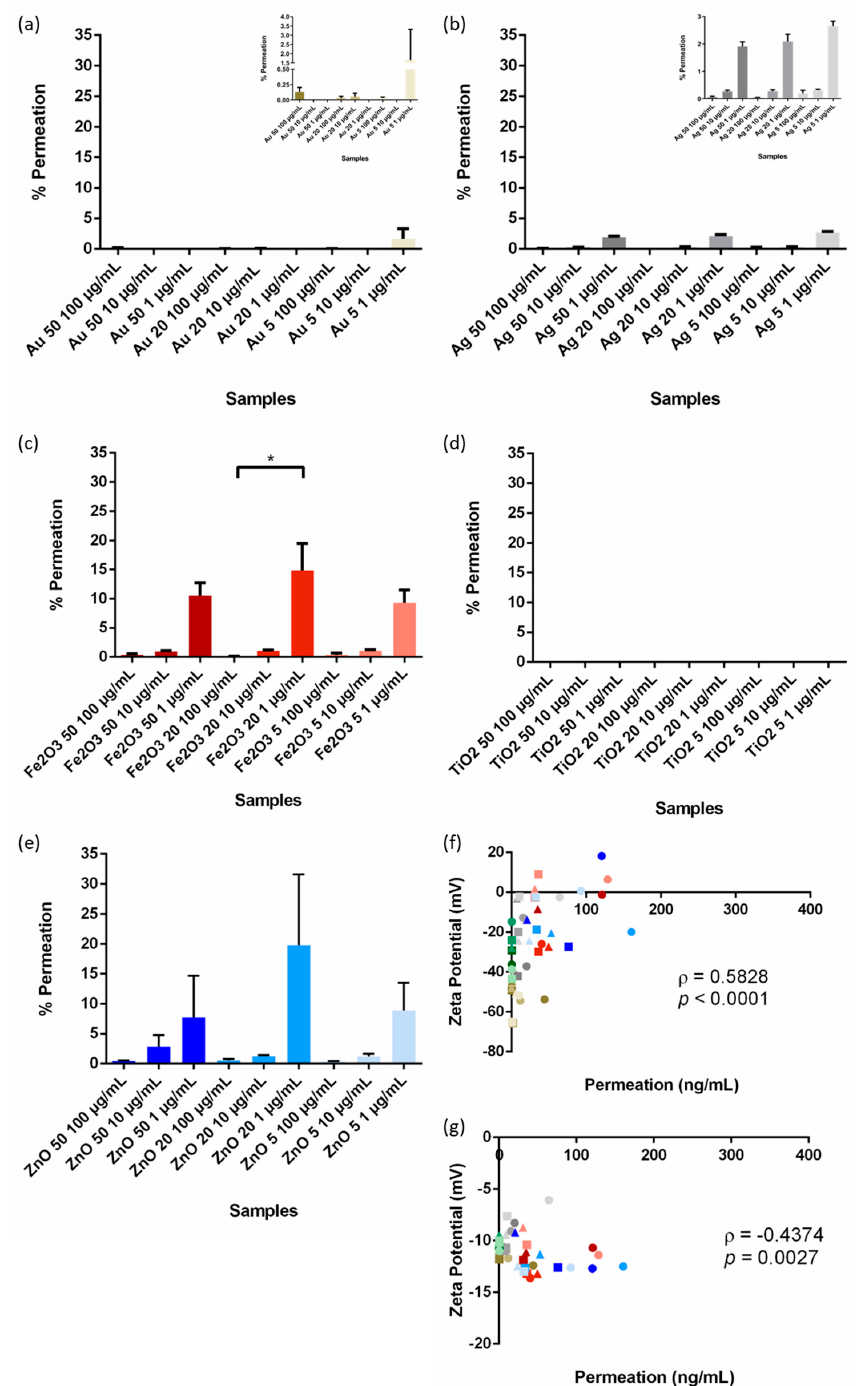
Figure 2. NP permeation across the cell barrier, as a percentage of the applied dose, following 12-h incubation with ( a ) gold, ( b ) silver, ( c ) iron (III) oxide, ( d ) titanium dioxide (there was no permeation of NPs found in all tests and all values found were zero i.e., the chart is blank), and ( e ) zinc oxide nanoparticles. For several samples, particularly all TiO 2 based NPs, no material could be detected by the ICP-MS in the permeate and hence the percentage permeation is noted as 0%. ( f ) Spearman’s correlation between NP permeability and nanoparticle zeta potential in water. ( g ) Spearman’s cor- relation between NP permeability and nanoparticle zeta potential in media. In the sca tt erplots ● = 100 µg/mL dose, ■ = 10 µg/mL, Δ = 1 µg/mL, * = 0.01 < p < 0.05. Note: levels were almost undetectable